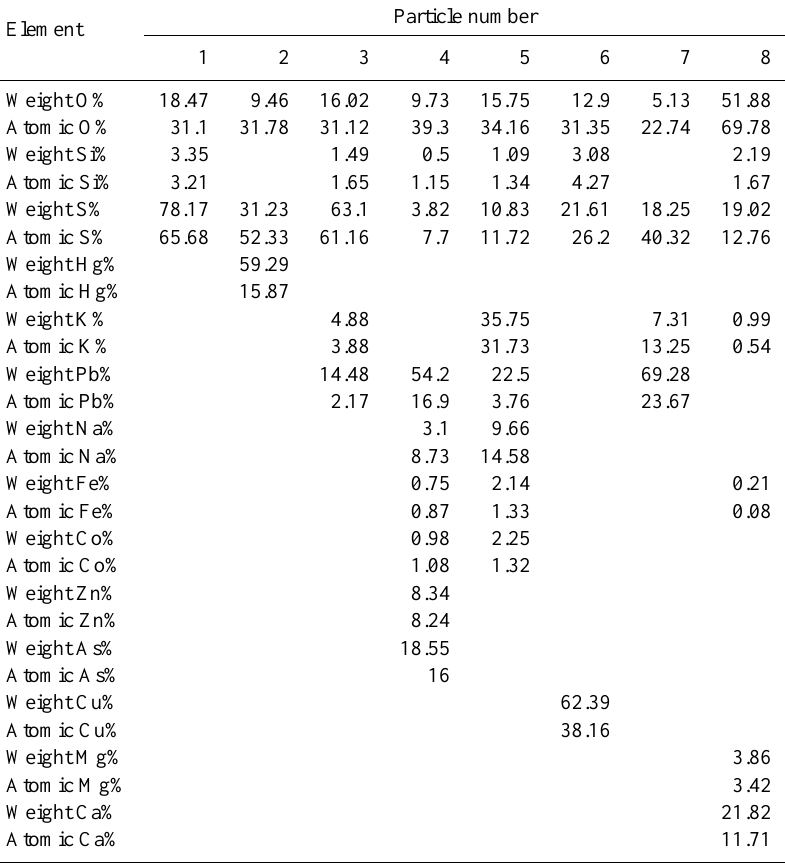
Table 2. EDX results for particles 1–8.